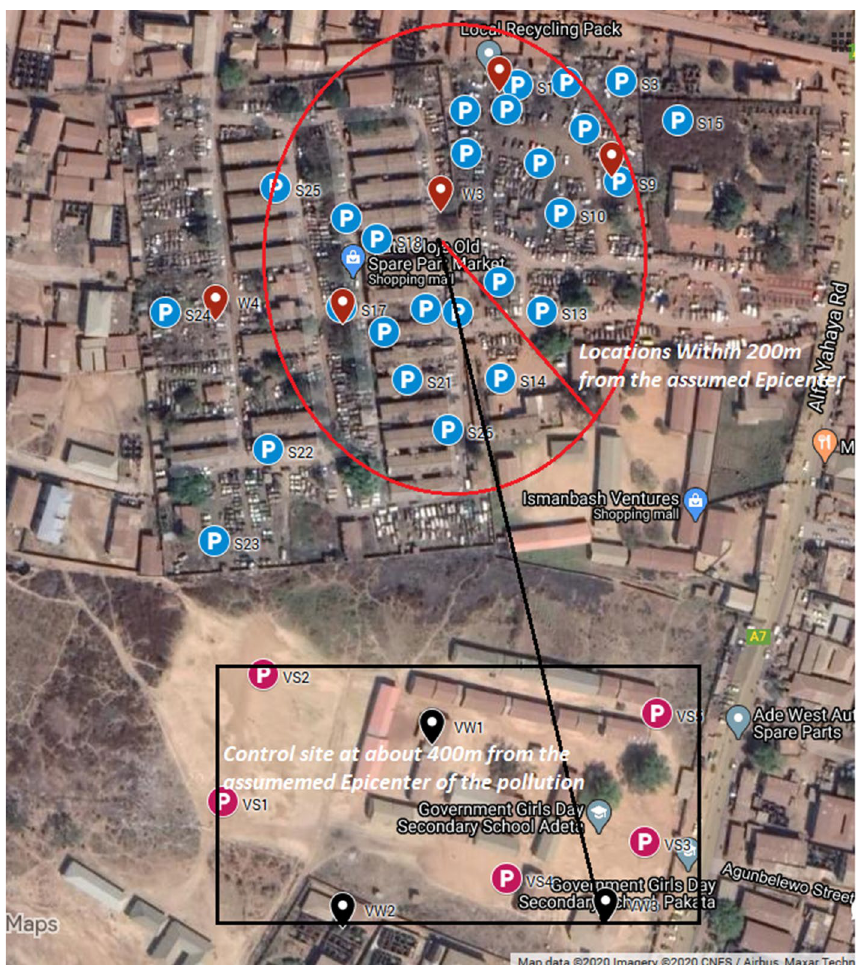
Figure 1. Satellite map of the study area showing sample locations (Available at: https ://www.googl e.com/ maps/d/u/0/edit?mid=1Umhq so1fr IWVxV 5aIrv MLoJX bHDGf